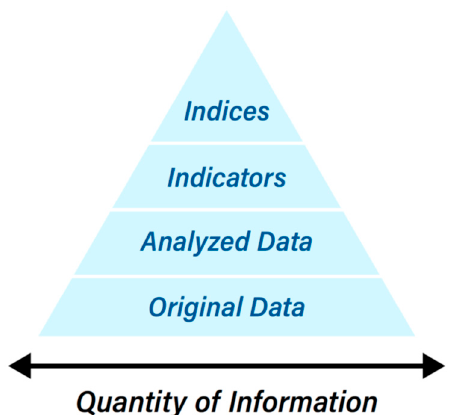
Figure 1. Data consolidation into indicators and goals. Source: [10].